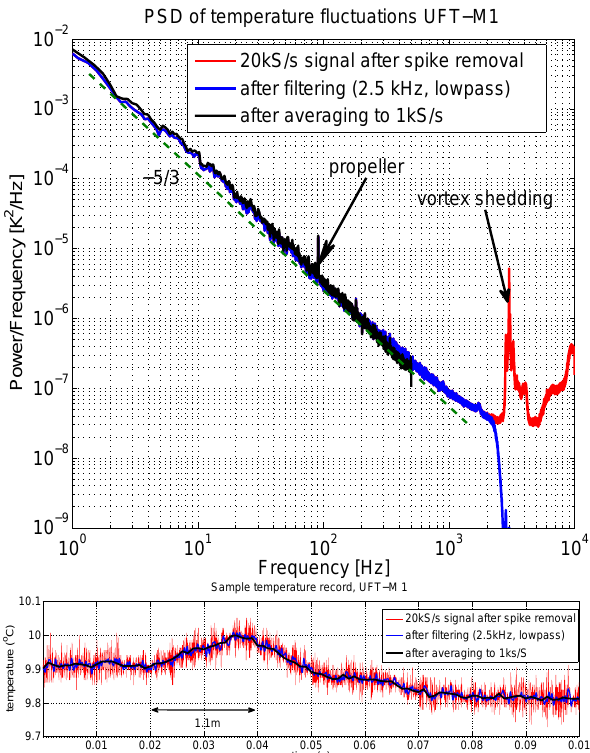
Fig. 7. Upper panel: power spectral density (PSD) of the tempera- ture fluctuations in the entrainment interfacial layer and inside the cloud. The red line represents a PSD of the 20kSs − 1 temperature signal after error corrections; blue line – PSD of the same signal that was digitally filtered with a 20th order low-pass Butterworth filter of 2.5kHz cutoff frequency; black line – PSD of the signal averaged to 1kSs − 1 . Lower panel: comparison of the unfiltered, filtered and averaged signal.